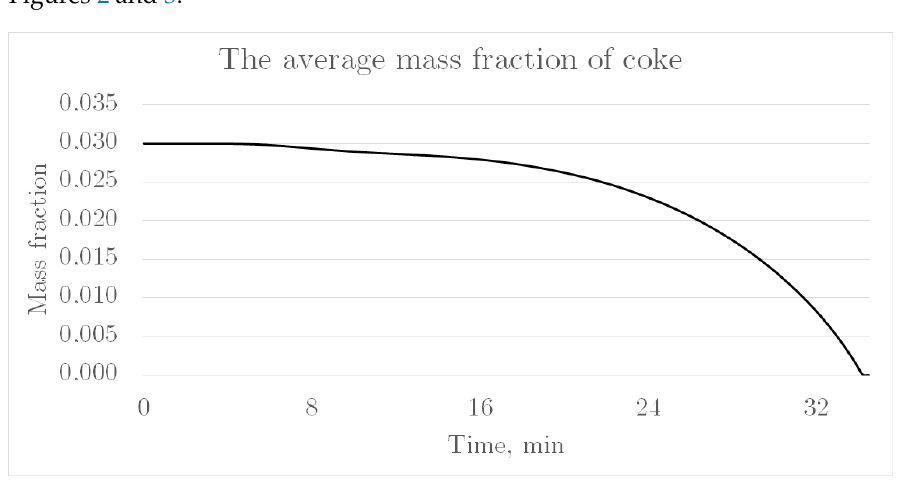
Figure 1. Dynamics of the average mass fraction of coke in the pores of the catalyst grain.